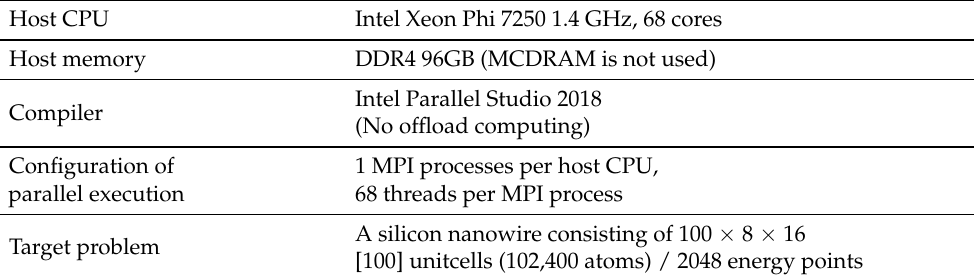
Table 4. Computing environment for multi-node scalability